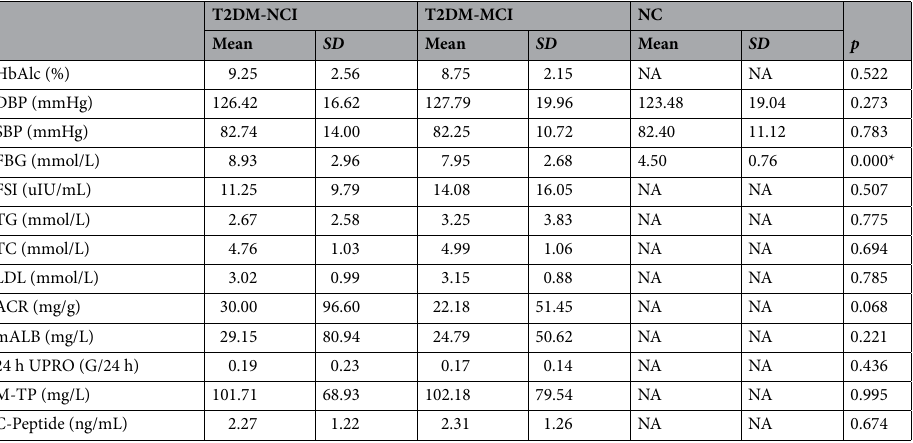
Table 3. Clinical results of T2DM-MCI, T2DM-NCI and NC groups. Data are shown as mean ± standard deviation, independent sample t-tests. *Data was considered significant different ( p < 0.05). HbA1c hemoglobinA1c, DBP diastolic blood pressure, SBP systolic blood pressure, FBG fasting blood glucose, FSI fasting serum insulin, TG triglyceride, TC total cholesterol, LDL low-density lipoprotein, ACR albumin/ creatinine ratio, mALB microalbuminuria, 24 h UPRO 24-h urinary protein, M-TP micro total protein.